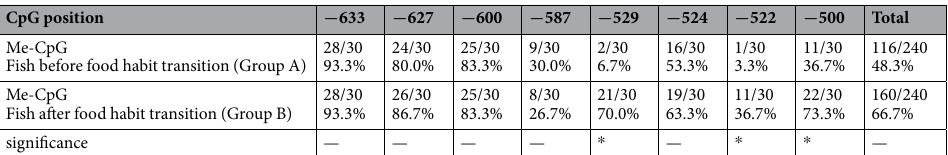
72.78 ± 6.15 mm, respectively), 6 fish were randomly selected from the group for sample collection. The fish were deeply anesthetized with MS-222 (200 mg L − 1 ) and killed by immediate spinal destruction for the measurement and dissection. The whole intestine of the grass carp before and after the food habit transition was collected and then frozen in liquid nitrogen and stored at − 80 °C for RNA and DNA isolation. Total RNA was extracted using Trizol Reagent (TaKaRa, Japan), and then its integrity and quantity were measured using protein and agarose gel electrophoresis and an Eppendorf Biophotometer (Hamburg, Germany). According to the manufacturer’s instructions, cDNAs were obtained from 1 µ g total RNA with the HiScript ® II Reverse Transcriptase (Vazyme Biotech, China) in a 20- μ L reaction volume. DNA methylation analysis.